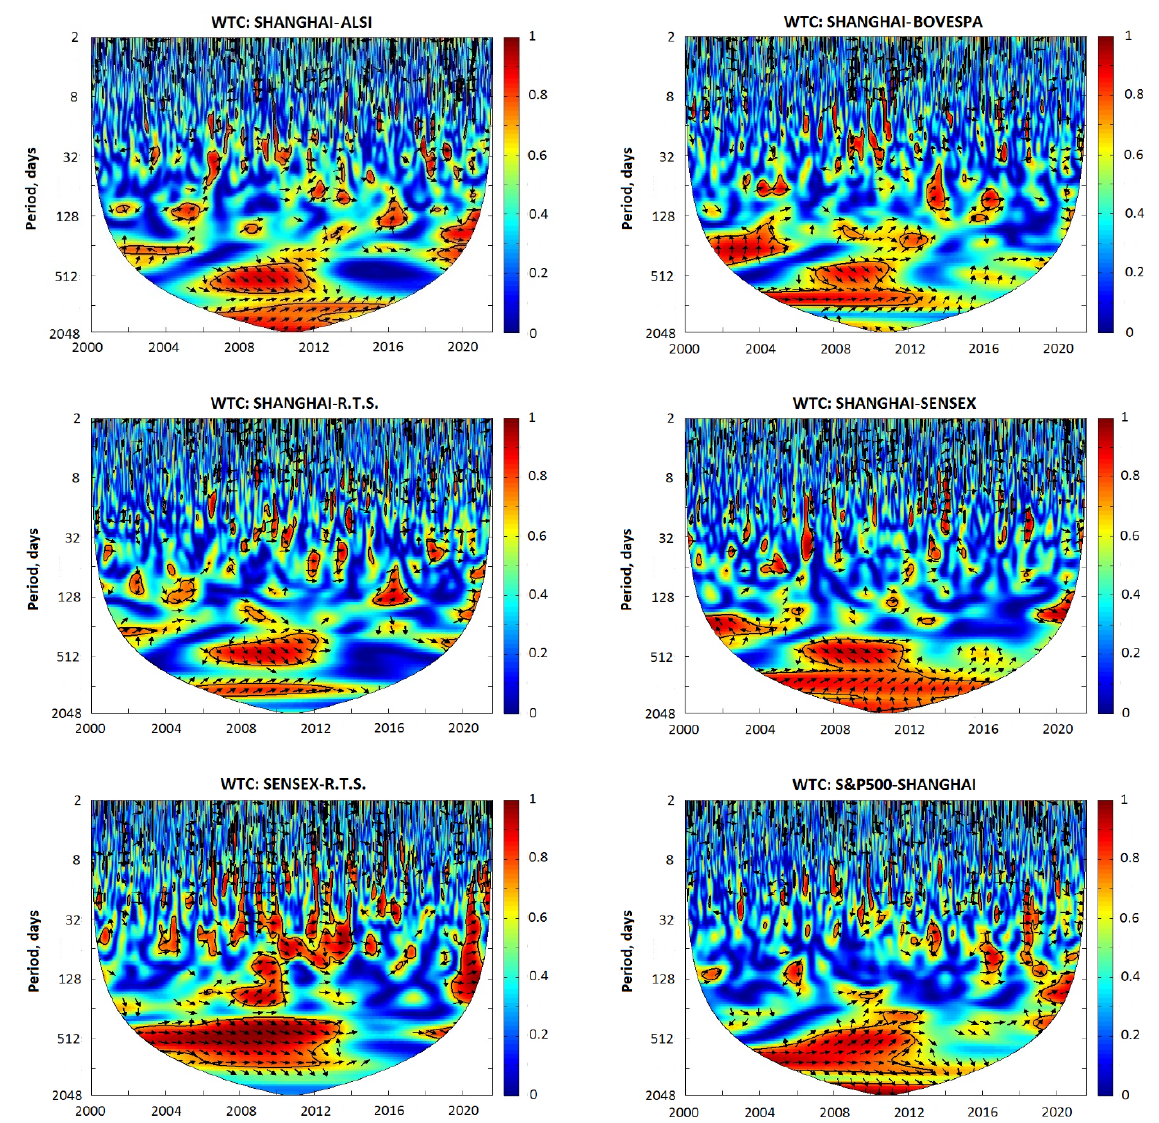
Figure 2. Wavelet squared coherence of stock returns of China with other BRICS and the US and India and Russia. The comovement level is measured in the range of lower correlation (blue) to higher correlation (red), as shown in the colour bar. The thick black contour indicates a 5% significance level against red noise. The relative phase relationship is shown as pointing arrows. Down: the first series leading the second series by 90 ◦ ; up: the second series leading the first series by 90 ◦ ; right: in-phase; left: